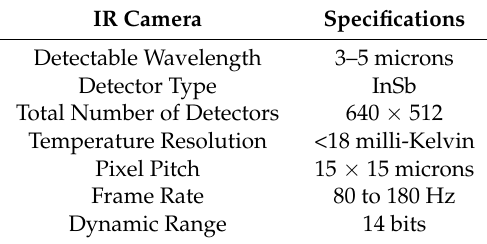
Figure 3. Passive thermography test setup ( a ) with IR camera view ( b ). Table 1. Specifications of the IR